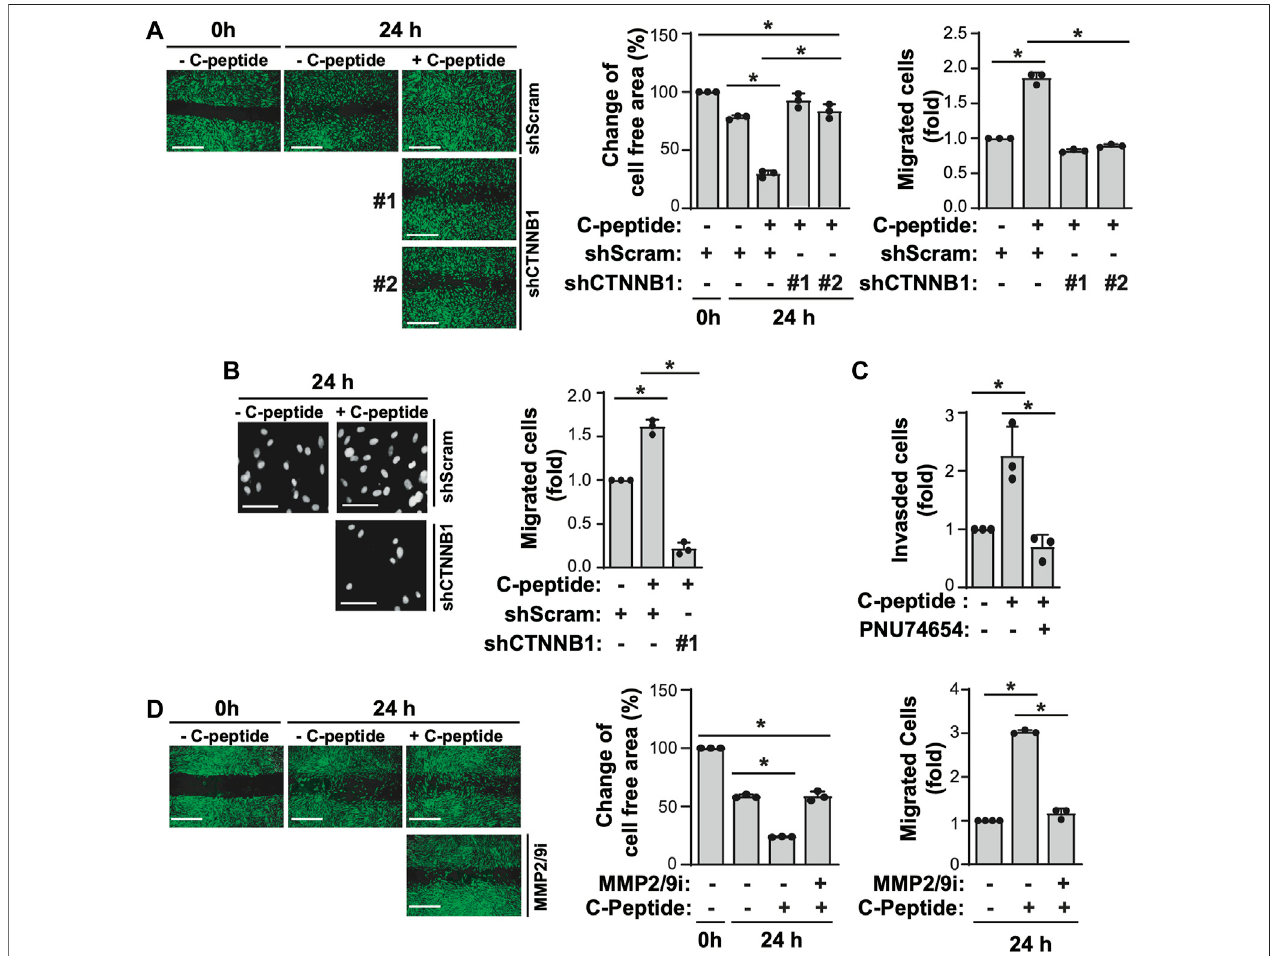
FIGURE 5 | β -catenin and MMP9 are critical for C-peptide-induced migration of undecidualized human endometrial stromal cells. (A) Undecidualized human endometrialstromalcells(UnD-ESCs)weretransducedusingshRNAsforscrambleand β -cateninandselectedfor5 dayswith1.5 μ Mpuromycin.Thecellswereserum- starved for 18 h, wounded using a T200 tip, incubated for 24 h with or without 50 nM C-peptide, visualized using the CytoPainter Cell Tracking Staining Kit and an Olympus CKX53 microscope (X4), and fi nally analyzed using ImageJ software. (B) UnD-ESCs were introduced with shRNAs and selected asdescribed in (A) , and then splitontranswell fi lters.C-peptide(50 nM)wasaddedtotheouter chamber ofeach fi lter.The cellswereincubated for24 h, stainedwithDAPI,andvisualizedusing an Olympus CKX53 microscope (X4). (C) UnD-ESCs were split on collagen-coated trans-wells, pretreated with 10 μ M PNU-74654 for 1 h, and then incubated for 24 h with or without 50 nM C-peptide, following the manufacturer ’ s instructions. (D) UnD-ESCs were serum-starved for 18 h, wounded using a T200 tip, pretreated with 10 μ M MMP2/9 inhibitor for 1 h, and then incubated with or without 50 nM C-peptide for 24 h. The cells were visualized using the CytoPainter Cell Tracking Staining Kit and an Olympus CKX53 microscope (X4), and then analyzed using ImageJ. Asterisks (*) indicate signi fi cant differences ( p < 0.05) when compared to the C-peptide- untreated UnD-ESCs control or C-peptide-treated UnD-ESCs control. Scale bar (cid:1) 100 μ m shScram, shRNA for scramble; shCTNNB1, shRNA for β -catenin; MMP2/9i, MMP2/MMP9